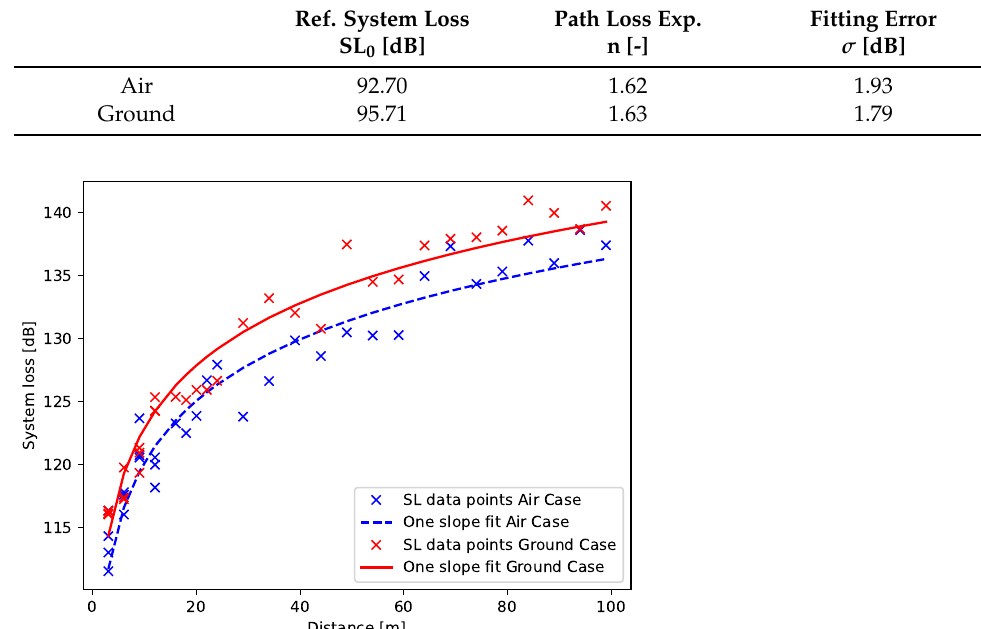
Figure 6. The fitted model (solid line) on the measured data (markers) for both propagation cases: in the air (blue) and on the ground